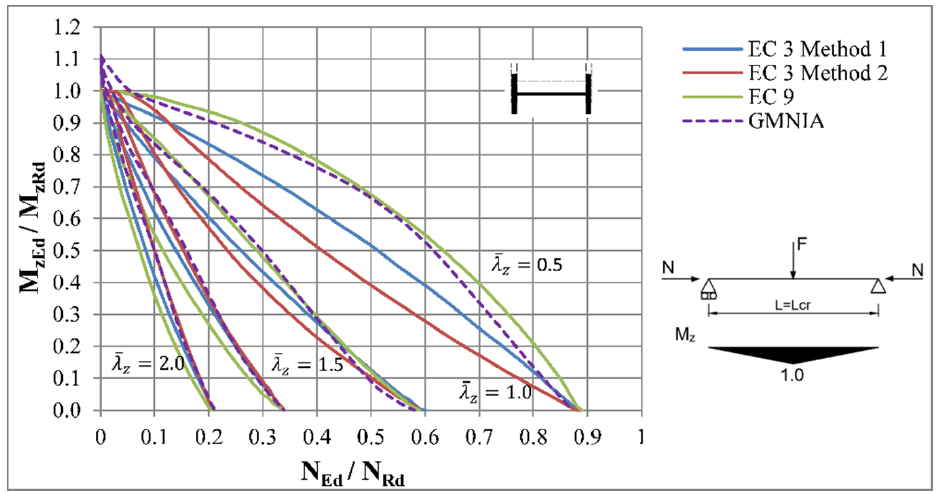
Figure 28. Interaction curves for weak axis flexural buckling of beam-columns with IPE 100 cross-section.